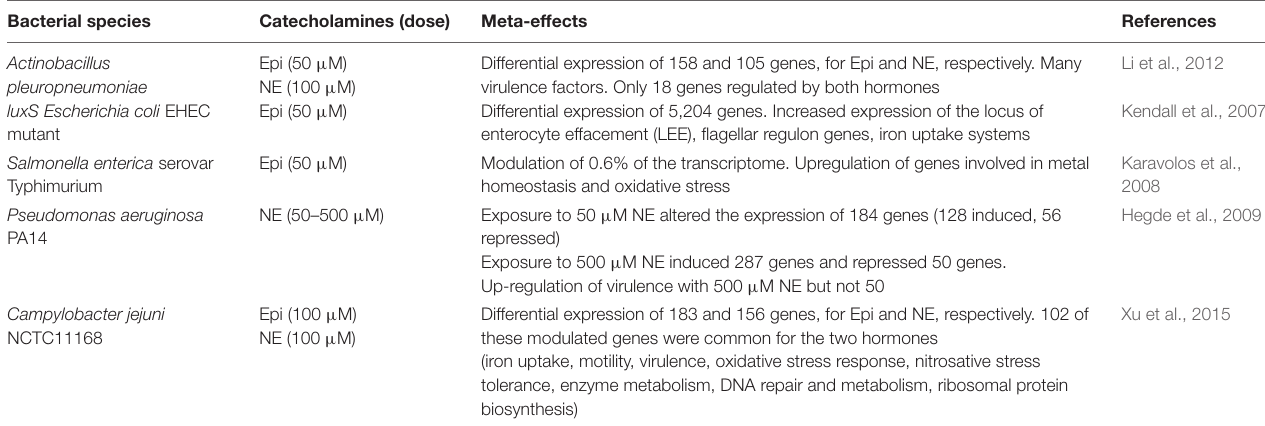
TABLE 7 | Meta-effects of catecholamines on bacteria studied by transcriptomic analysis. Bacterial